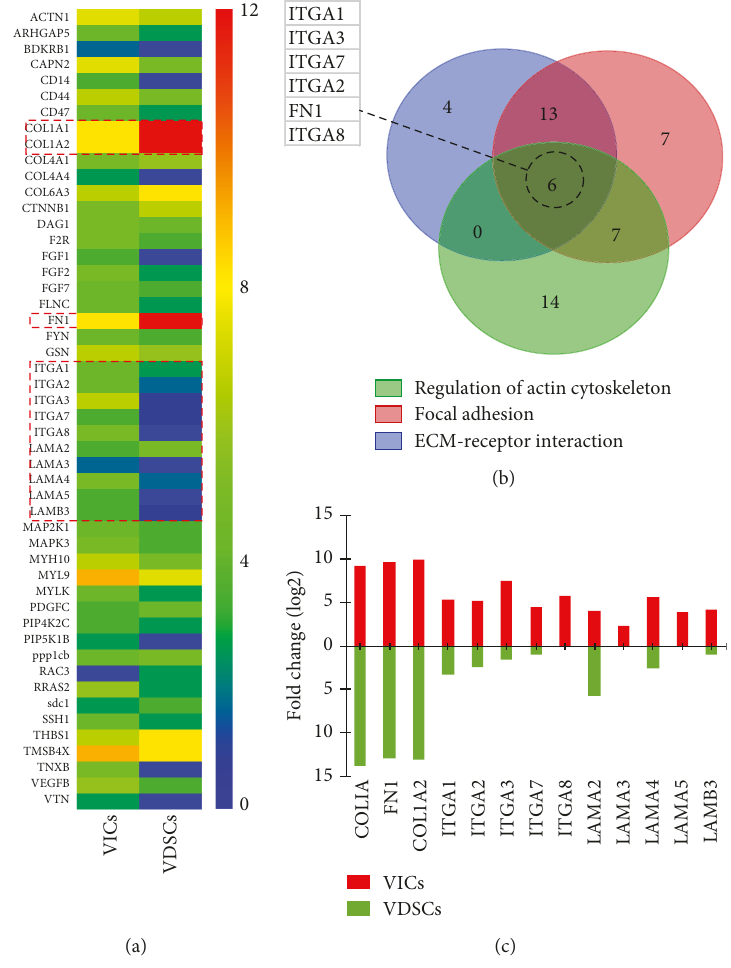
Figure 5: Signi fi cant pathways (ECM-receptor interaction, focal adhesion, regulation of actin cytoskeleton, and cell cycle) were selected for further signi fi cant DEG analysis. (a) Heat maps for typical selected functional DEGs based on previous selected pathways, (b) Venn interaction of DEGs, and (c) selected ECM-related DEG fold change in VICs and